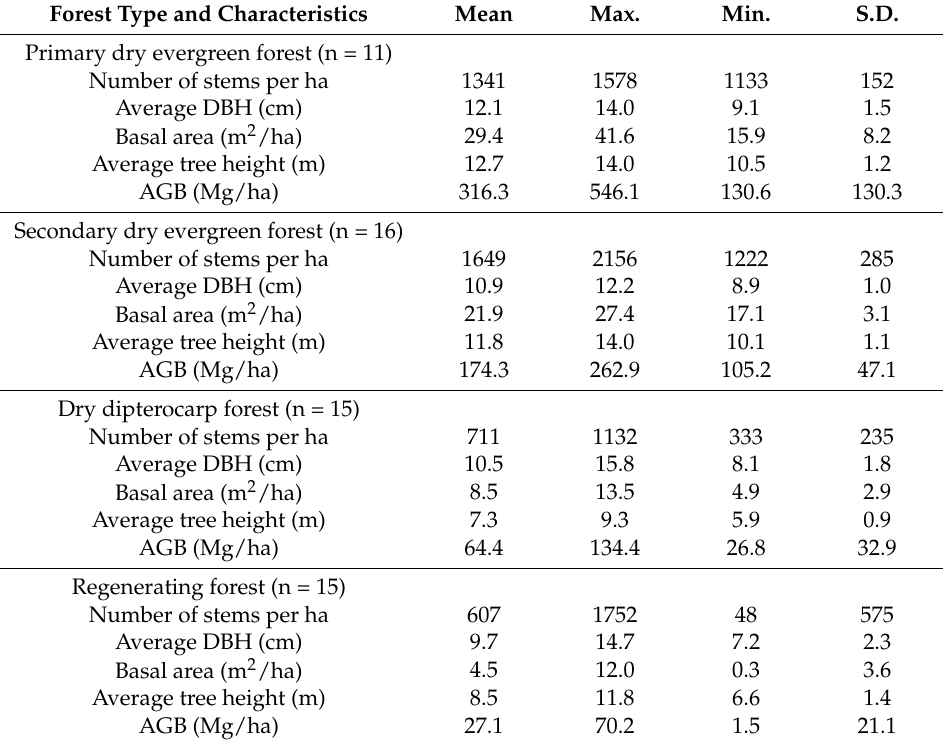
Table 2. Summary statistics for the four main forest types in the field sample